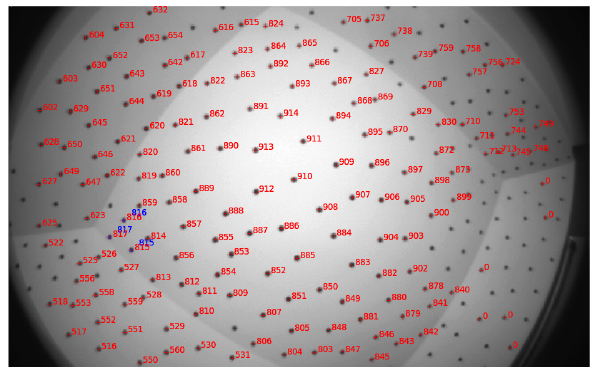
Figure 3: 3D test field imaged with a strongly distorting lens. Bottom right edge corresponds to the bottom edge in figure 2. Blue numbers were manually given as initial reference points. Red numbers were automatically found. Zero (0) indicates, that no suitable label was found. Few markers have not been identified as markers by the image pre-processor.